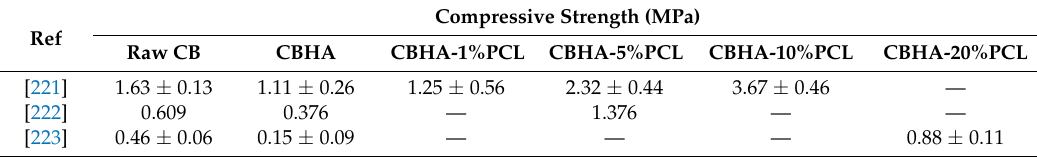
Table 2. Compressive strength of raw CB, CBHA, and the different percentages of PCL coating on